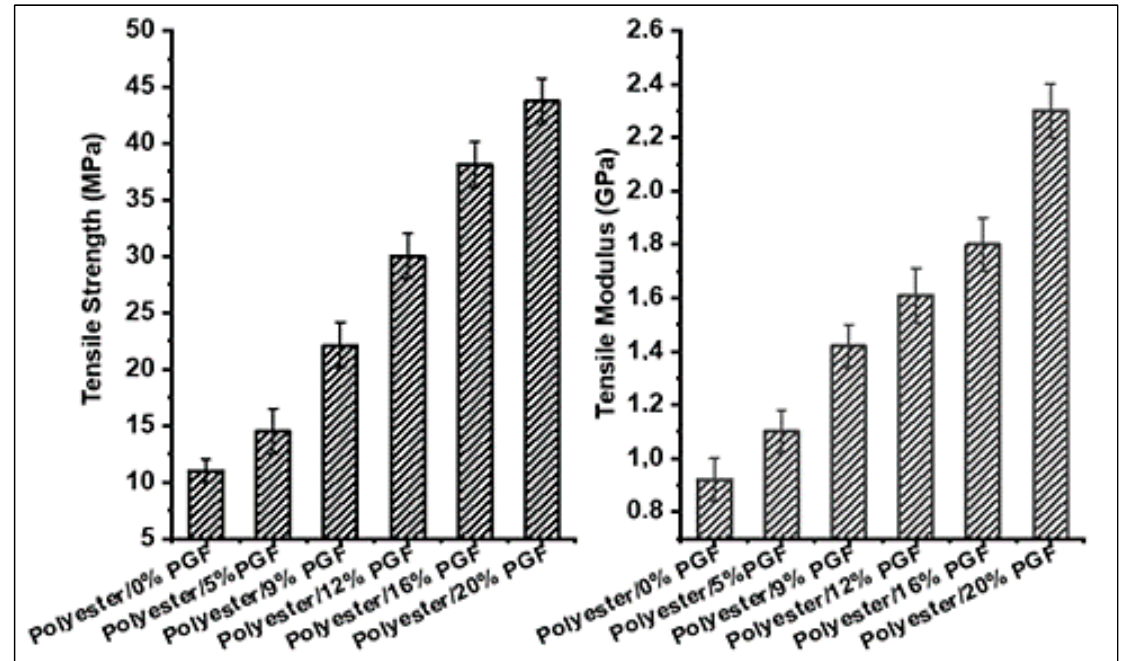
Figure 8. Effect of phosphate glass fiber content on the tensile strength and modulus. Flexural Testing